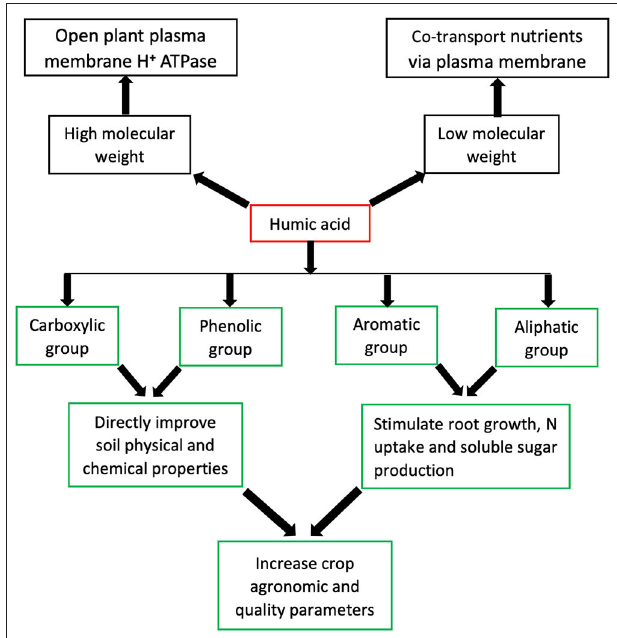
FIGURE 1 | Graphical representation of humic acid, its chemical and molecular constitutes and functions.